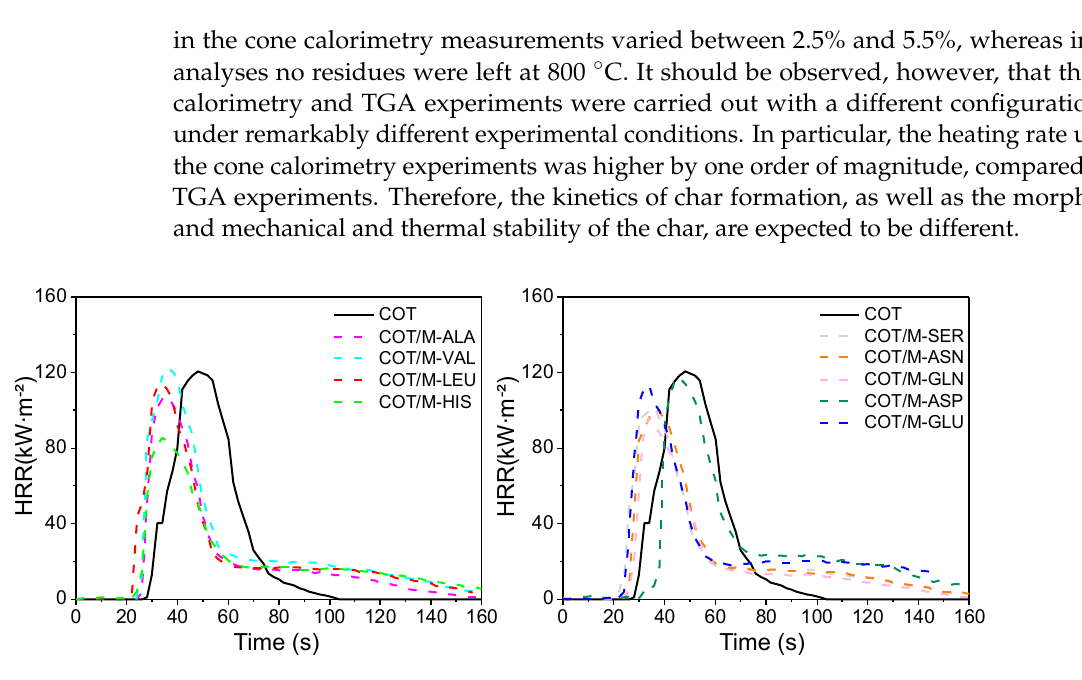
Figure 10. Heat release rate curves of untreated and 7% add-on, PAA-treated cotton fabrics. Table 8. Combustion data of untreated and PAA-treated cotton fabrics (add-on: 7%) from cone calorimetry.